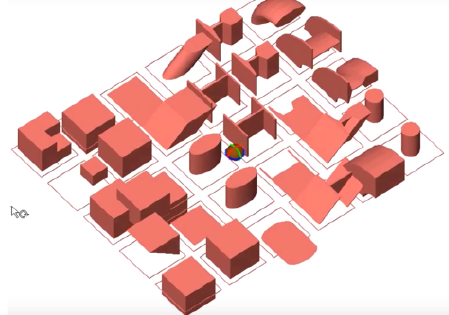
Figure 6. A view of the IFC geometries as visualised in the FZK viewer.